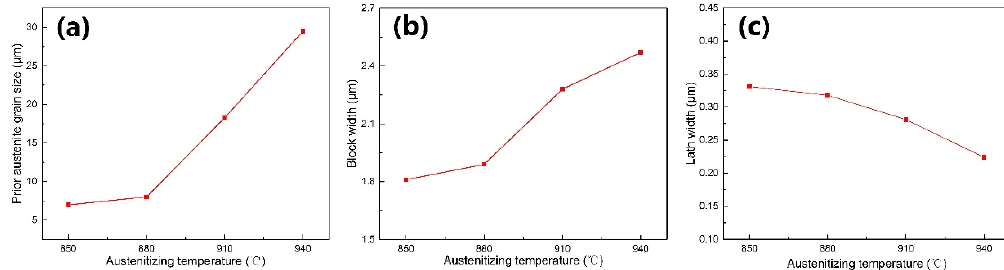
Figure 3. Relationship between austenitizing temperature and ( a ) prior austenite grain size, ( b ) block width, and ( c ) lath width.